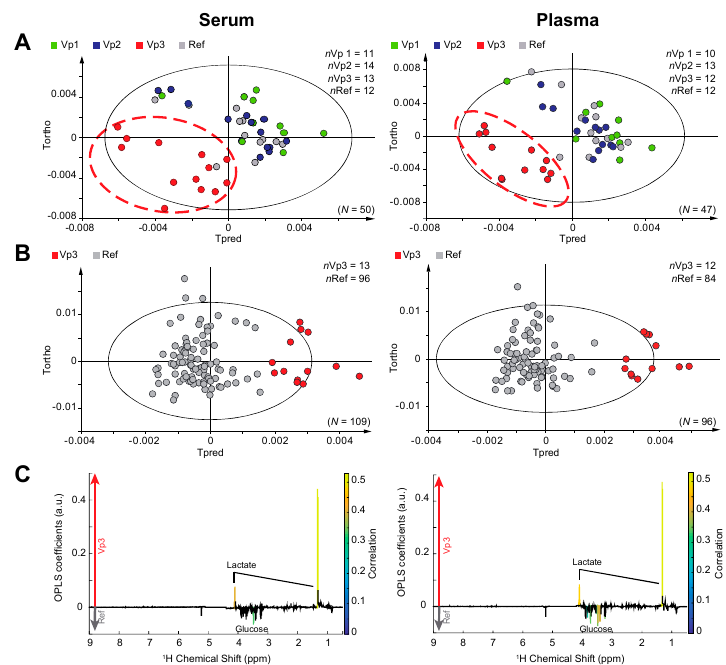
Figure 1. Impact of the delay and storage temperature between blood draw and centrifugation on plasma and serum metabolic profiles. ( A ) Partial least squares discriminant analysis (PLS-DA) model for serum cohort, discriminating variant (Vp) 1, Vp2, Vp3 and a reference (Ref) group ( N = 50, n Vp1 = 11, n Vp2 = 14, n Vp3 = 13, n Ref = 12, 1+1 components, R 2 Y = 0.267, Q 2 = 0.192) and for plasma cohort ( N = 47, n Vp1 = 10, n Vp2 = 13, n Vp3 = 12, n Ref = 12, 1+1 components, R 2 Y = 0.283, Q 2 = 0.204). The Ref group corresponds to a random mix of samples collected according to the reference protocol Patients in the Ref group also underwent the variant protocol Vp1, Vp2 or Vp3; ( B ) Orthogonal projections to latent structures (OPLS) model for serum cohort, discriminating Vp3 vs. Ref samples ( N = 109, n Vp3 = 13, n Ref = 96, 1+2 components, R 2 Y = 0.7, Q 2 = 0.652, ANOVA of the cross-validated residuals (CV-ANOVA) p -value = 2.7 × 10 − 21 ); OPLS model score plot for plasma cohort, discriminating samples Vp3 vs. Ref samples ( N = 96, n Vp3 = 12, n Ref = 84, 1+2 components, R 2 Y = 0.796, Q 2 = 0.771, CV- ANOVA p -value = 1.9 × 10 − 26 ); ( C ) OPLS loading plot is represented for Vp3 vs. Ref serum samples; OPLS loading plot is represented for Vp3 vs. Ref plasma samples. Statistically significant individual signals correspond to the color spectral regions. Tpred and Tortho correspond to the predictive component and orthogonal component of the OPLS model, respectively.